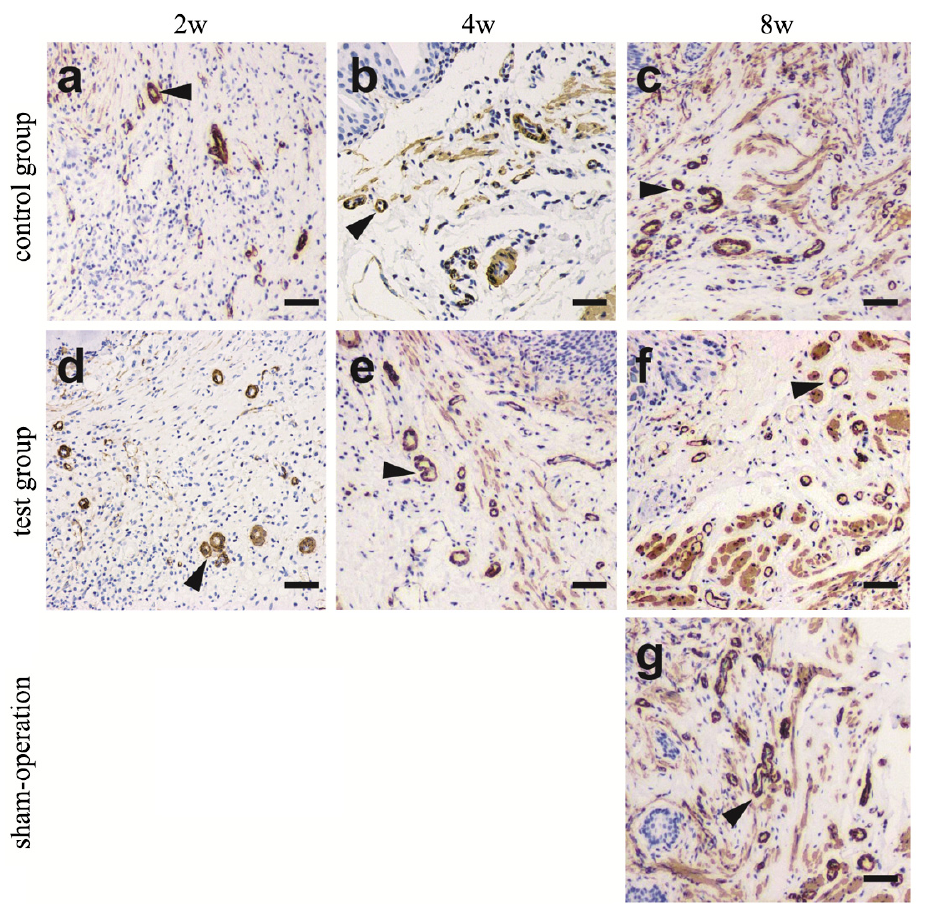
Figure 5. Immunohistochemical staining with α -SMA to trace the formation of blood vessels. At 2nd, 4th, and 8th week after surgery, the blood vessels regeneration in control group ( a – c ) and test group ( d – f ). With the passage of time (2w to 8w), the number of blood vessels gradually increased, especially in the test group( d – f ). At the 8th week, the blood vessels in the control group ( c ) and the experimental group ( f ) were not as thick as those in the sham-operation group ( g ). Arrowheads indicate vessels. (Scale bar = 50 µm).